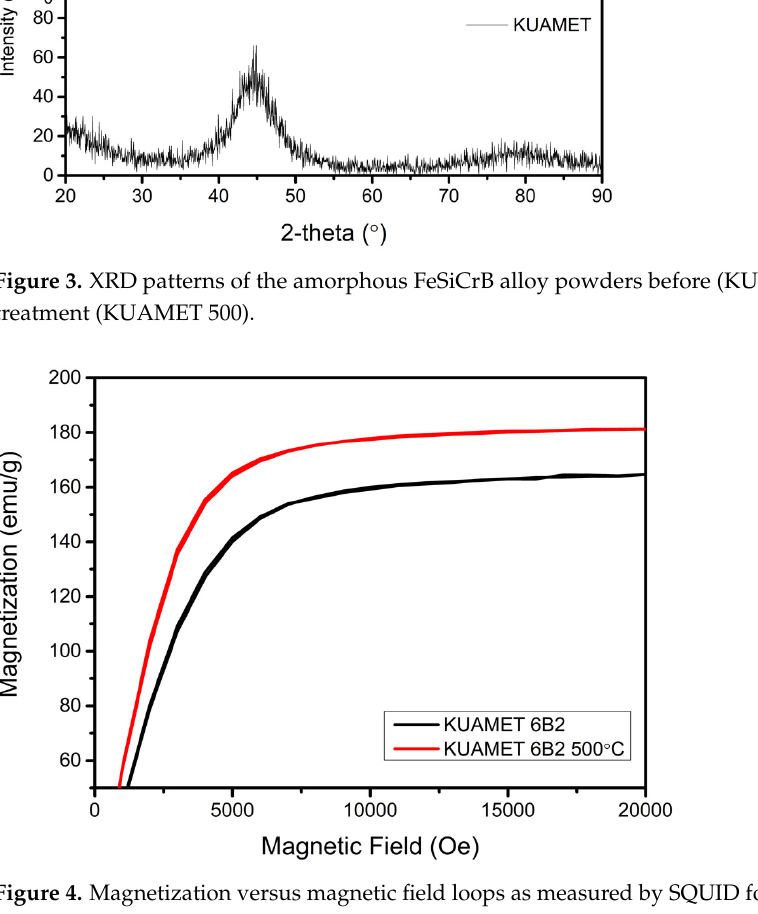
Figure 4. Magnetization versus magnetic field loops as measured by SQUID for amorphous FeSiCrB alloy powders before and after heat treatment. alloy powders before and after heat